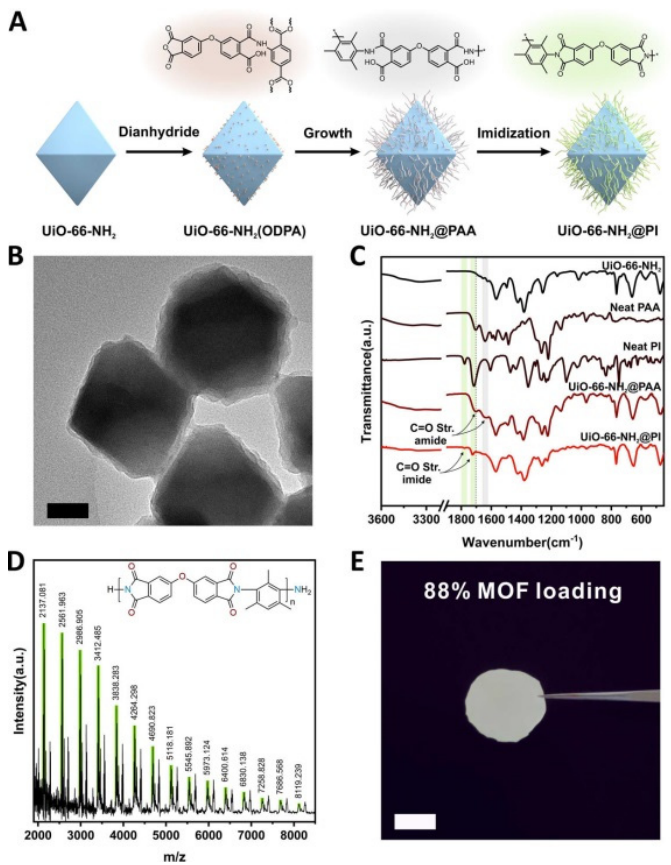
Figure 16. ( A ) Synthetic procedures of UiO-66-NH 2 @PI. ( B ) The TEM image of UiO-66-NH 2 @PI, scale bar 50 nm. ( C ) FT-IR spectra of UiO-66- NH 2 , polymers, and modified UiO-66-NH 2 and ( D ) the MALDI-TOF spectrum of the digested UiO-66-NH 2 @PI. The peaks highlighted in green correspond to the given polymer structure. ( E ) The photo of a stand-alone single component UiO-66-NH 2 @PI membrane with 88 wt % MOF loading, scale bar 5 mm. Reprinted with permission from [140], Copyright (2018) American Chemical Society.